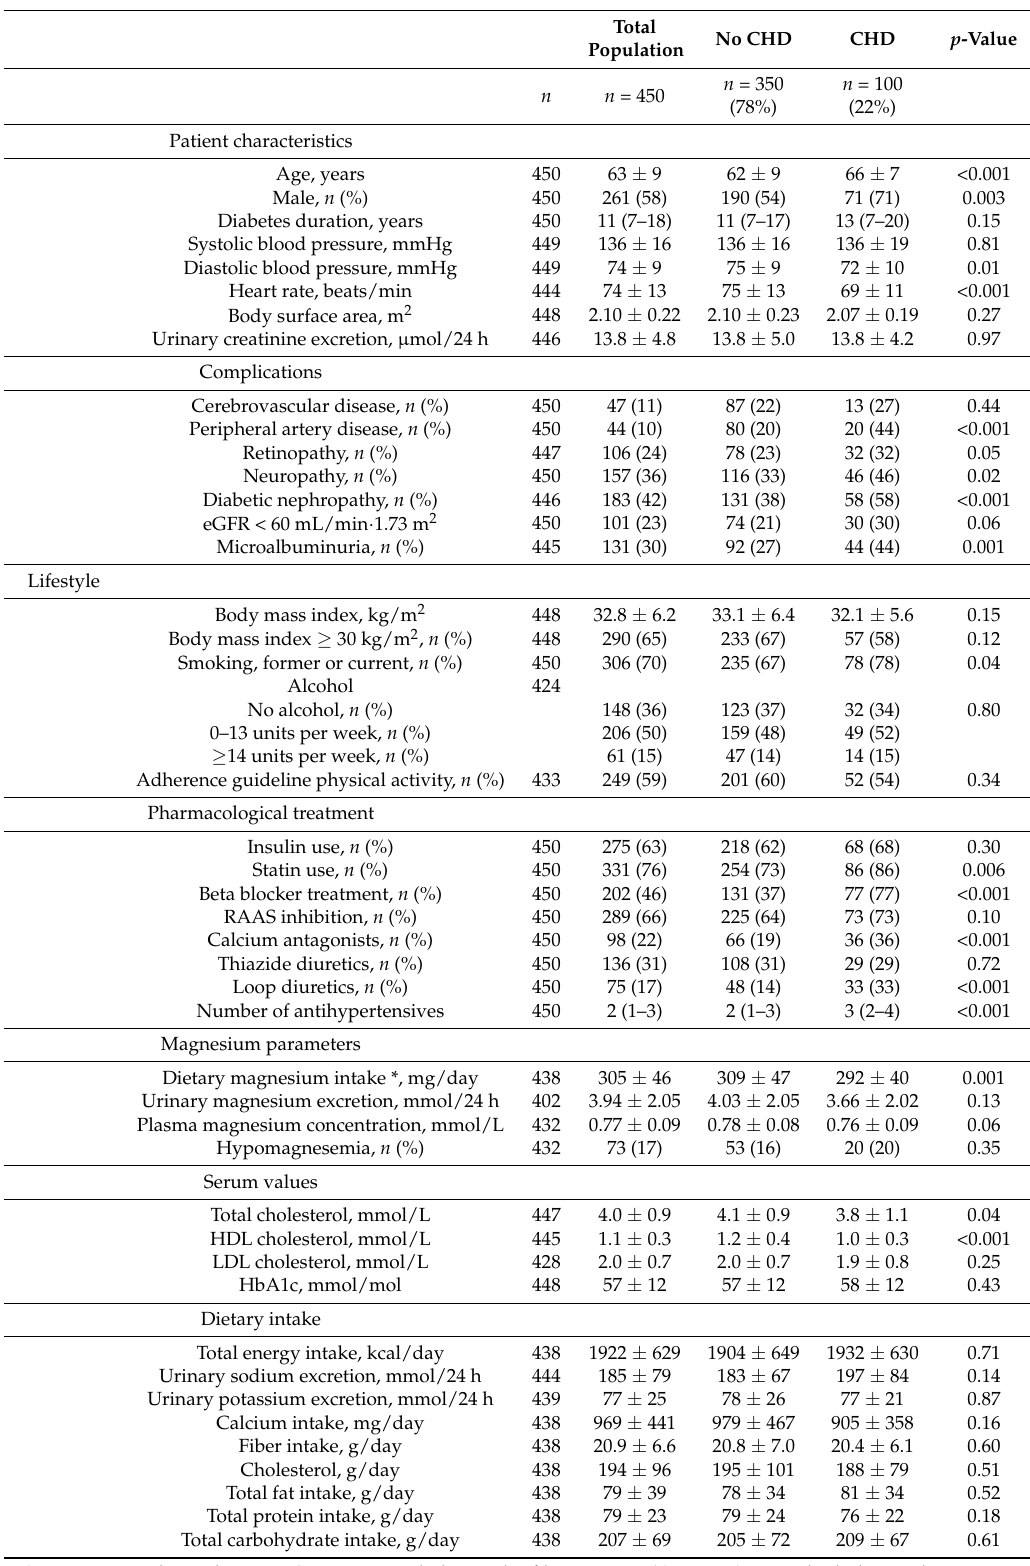
Table 1. Baseline characteristics of patients with type 2 diabetes mellitus (T2D) by a breakup of prevalent coronary heart disease